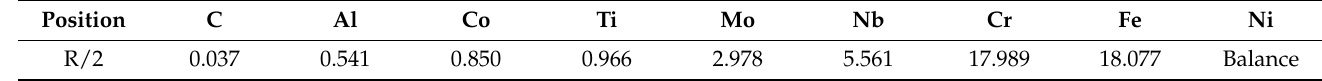
Table 1. Chemical composition of as-cast superalloy GH4169 (wt